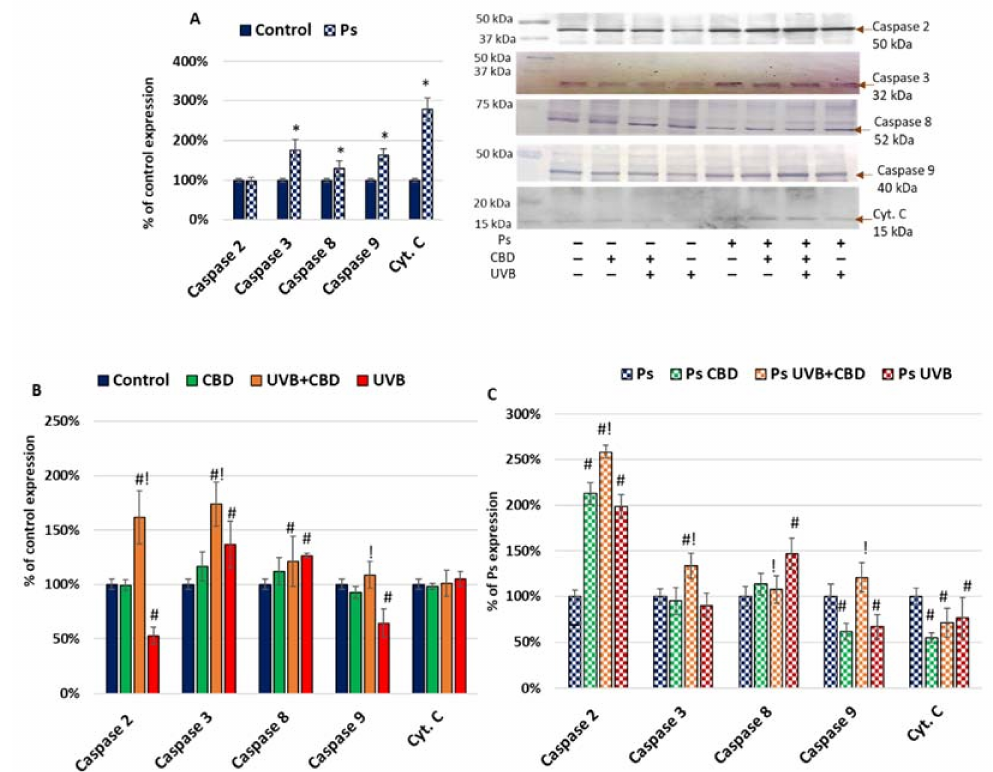
Figure 1. ( A ) Expression of apoptosis markers in keratinocyte cell lines from healthy subjects (Control; n = 5) and psoriatic patients (Ps; n = 5). Here, 100% corresponds to the level of protein in healthy keratinocytes untreated with UVB or CBD. The mean values ± SD are presented with statistically significant differences: * between keratinocytes from patients with psoriasis vulgaris and healthy subjects, p < 0.05. ( B ) Expression of apoptosis markers in keratinocyte cell lines from healthy subjects (Control; n = 5) without treatment and after irradiation with UVB (60 mJ/cm 2 ) and/or incubation with CBD (4 µ M). Here, 100% corresponds to the level of protein in healthy keratinocytes untreated with UVB or CBD. The mean values ± SD are presented with statistically significant differences: # between keratinocytes treated with CBD, UVB and UVB+CBD and nontreated, p < 0.05; ! between keratinocytes treated with UVB+CBD and irradiated with UVB, p < 0.05. ( C ) Expression of apoptosis markers in keratinocyte cell lines from psoriatic patients (Ps; n = 5) without treatment and after irradiation with UVB (60 mJ/cm 2 ) and/or incubation with CBD (4 µ M). Here, 100% corresponds to the level of protein in psoriatic keratinocytes untreated with UVB or CBD. The mean values ± SD are presented with statistically significant differences. # between keratinocytes treated with CBD, UVB and UVB+CBD and nontreated, p < 0.05; ! between keratinocytes treated with UVB+CBD and irradiated with UVB, p <